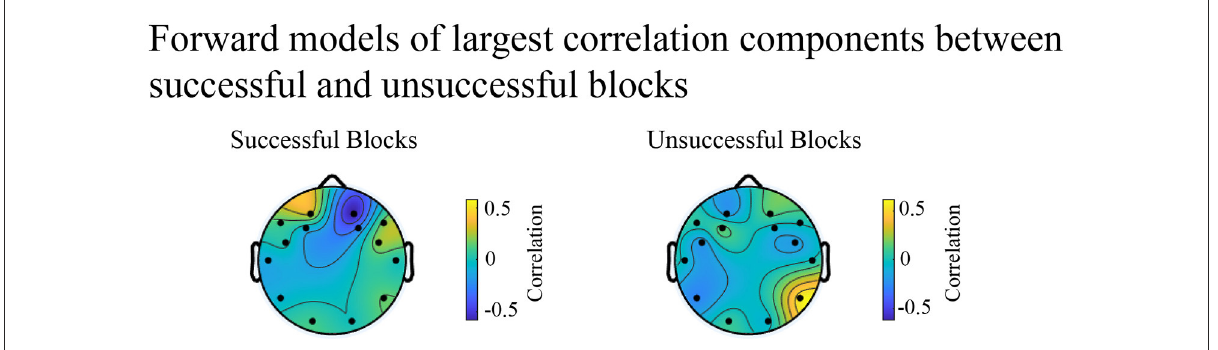
FIGURE12 Spatial distribution of between subject correlations shows no consistent pattern of neural activity across story blocks in engage and view states.